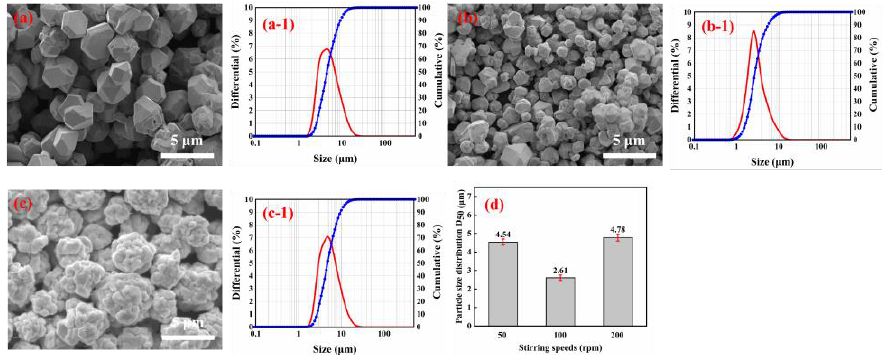
Figure 8. SEM images of silver particles prepared with different stirring speeds: ( a ) rpm = 50; ( b ) rpm = 100; ( c ) rpm = 200; ( d ) Variation of the average size of silver particles (D 50 ) with stirring speeds. Size distribution of silver particles prepared with different stirring speeds: (a - 1) rpm = 50; (b - 1) rpm = 100; (c - 1) rpm = 200.